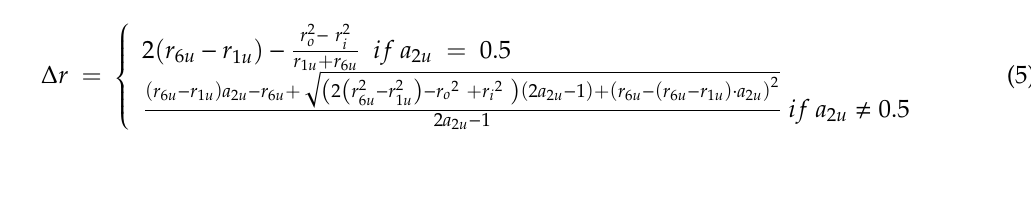
8 of 21 Figure 6. Possible upper coil (UC) supply strategies with concordant ( A , B ) or discordant ( C , D ) current polarities; the orange and black arrows indicate the permanent magnet (PM) and coil flux directions,